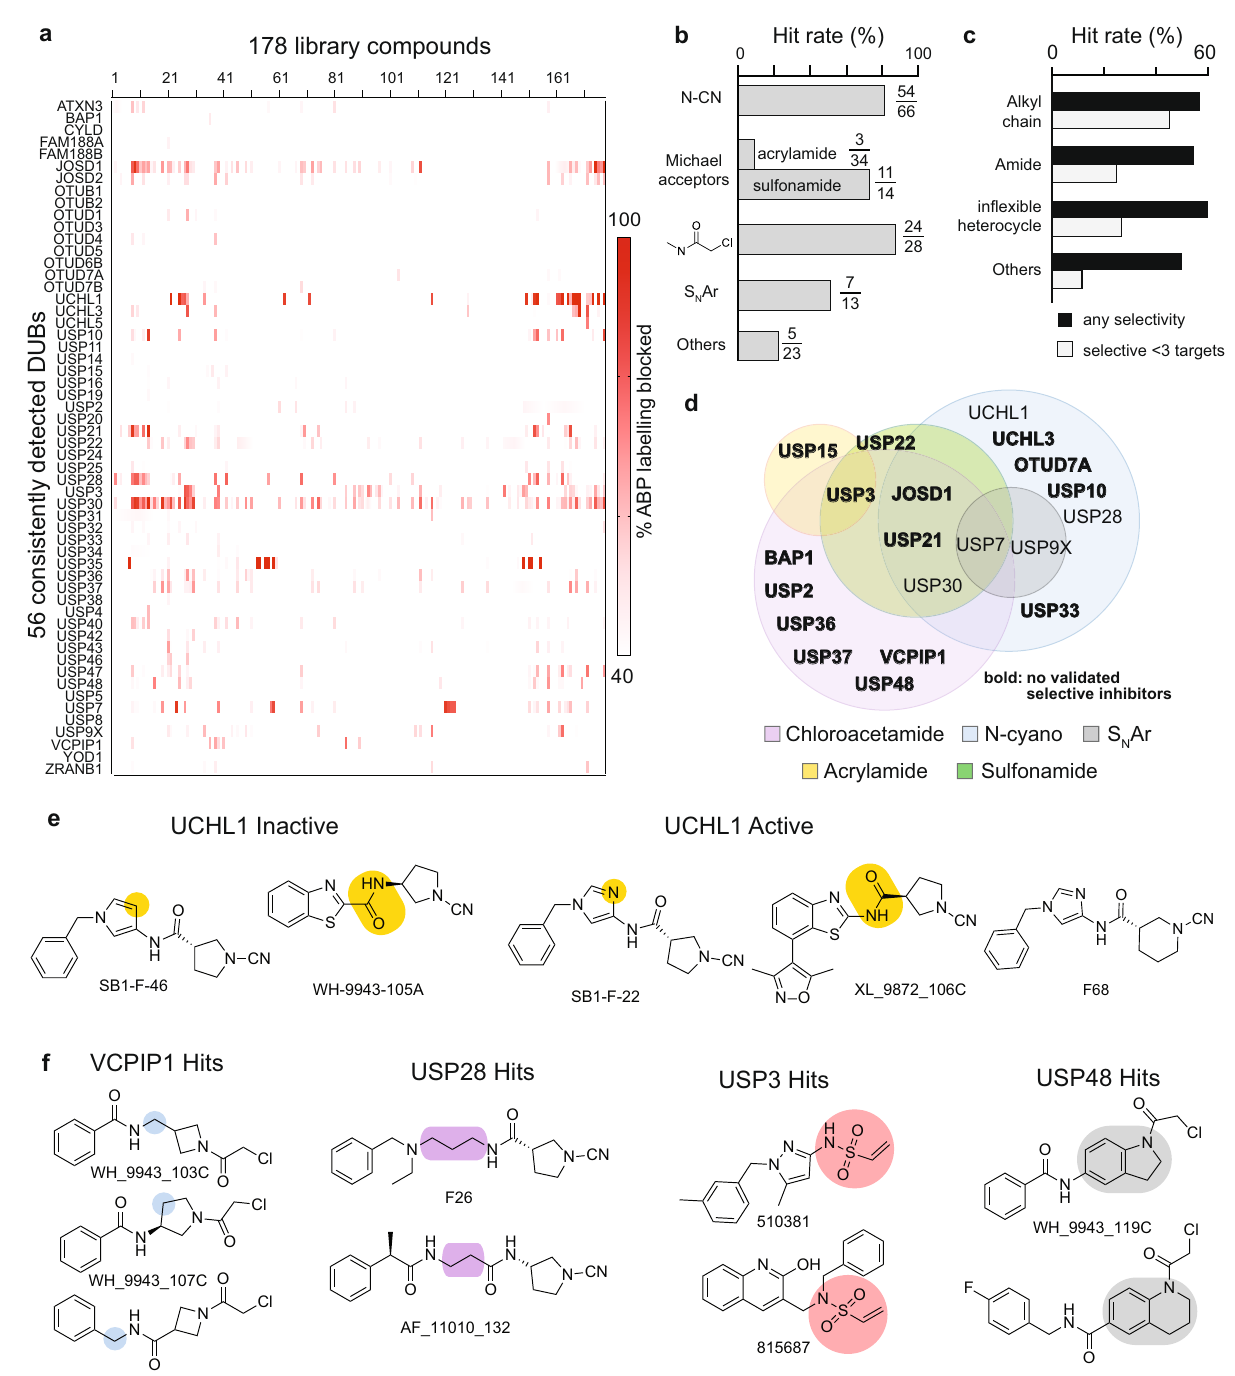
Fig. 3 | Chemical trends in primary screening. a Heatmap representing potency and selectivity data for all 178 library compounds against 56 DUBs detected con- sistently over 80% of runs. b Electrophiles displayed diverse DUB hit rates. Acry- lamidesexhibited pooractivitytowardsDUBcatalyticcysteines.Insetsadjacentto each bar indicate the number of hits and the total number of compounds con- taining each electrophile. c Presence and type of linker in fl uenced compound activity and selectivity. d Individual warheads showed partially overlapping DUB targetpro fi les.Venndiagramiscoloredbywarhead,legendin fi gure.BoldedDUBs